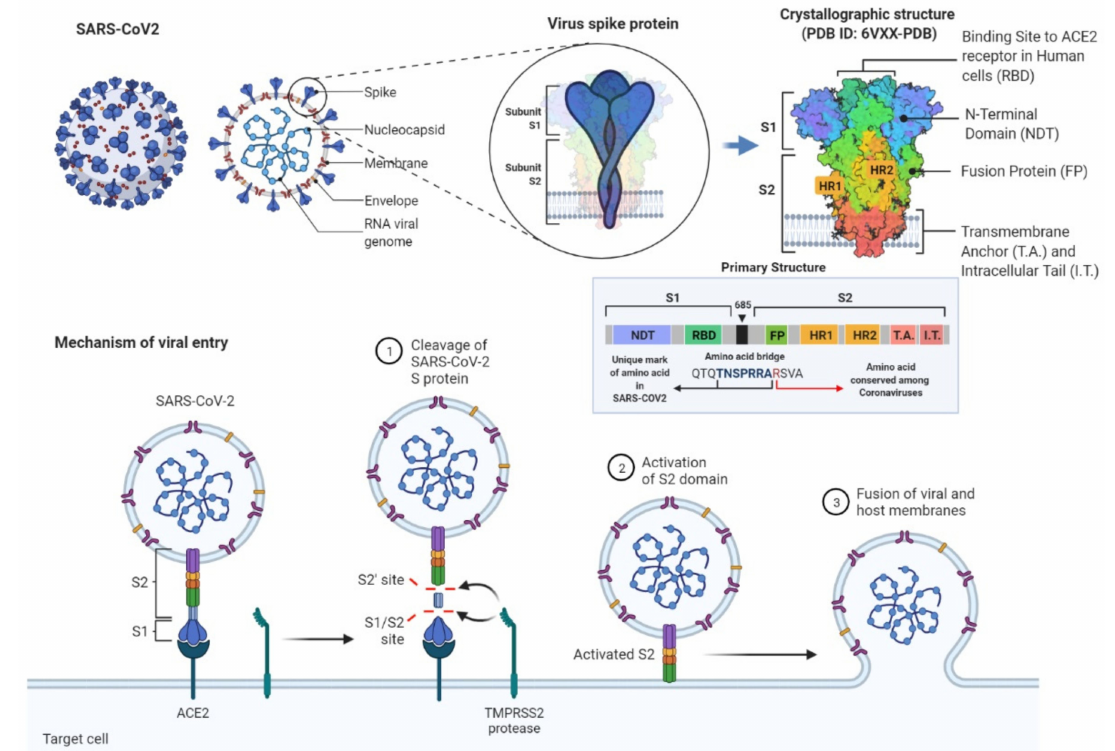
Figure 1. The schematic representation of the SARS-CoV-2 and its surface spike protein structure with their structural descriptions and detailed mechanisms of the viral entry to cells during infection. Spike protein plays a crucial role in this process. While S1 subunit is responsible for anchoring the virion by binding to the cellular receptor angiotensin-converting enzyme 2 (ACE2) of the host cell, S2 subunit enhances the fusion of the viral and the host cell membranes. The fusion is mediated by the S2 subunit that is activated by the transmembrane protease serine 2 (TMPRSS2) cleaving the spike protein at the S1/S2 sites. Adapted from “An In-depth Look into the Structure of the SARS-CoV2 Spike Glycoprotein”, “Human Coronavirus Structure” and “Mechanism of SARS-CoV-2 Viral Entry” by BioRender.com (accessed on 30 November 2021)